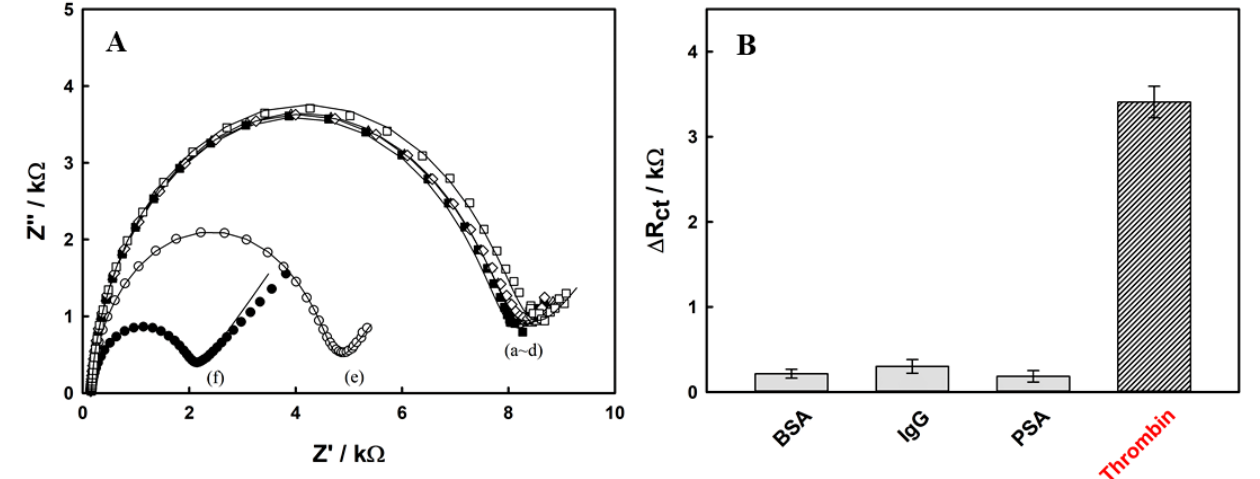
Figure 4. ( A ) Impedance spectra at TBA ‐ modified SWCNT/SPCE (a) before and after (b − e) incubation with protein: (b) 150 nM PSA, (c) 120 nM IgG, (d) 200 nM BSA, or (e) 100 nM thrombin in the presence of 0.1 mM Fe(CN) 63 − /0.1 mM Fe(CN) 64 − (1:1 molar ratio) and 0.1 M KNO 3 in EB. (f) Nyquist plot of SWCNT/SPCE without TBA under same electrolyte conditions. Solid curves represent the fitting results from an equivalent circuit. ( B ) Plot of the corresponding ∆ R ct . ∆ R ct = R ct,0 − R ct,p . R ct,0 is the R ct in the absence of protein and R ct,p is that in the presence of each protein. Errors bars are ob ‐ tained based on three independent measurements.